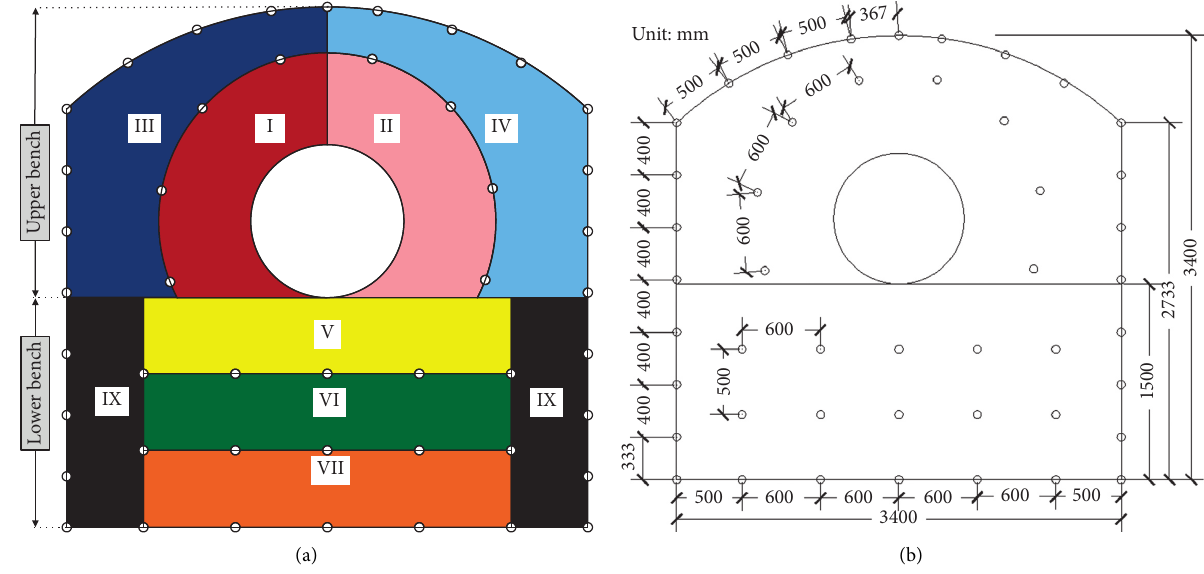
Figure 12: Rock fracturing scheme. (a) Excavation process. (b) Layout of rock fracturing